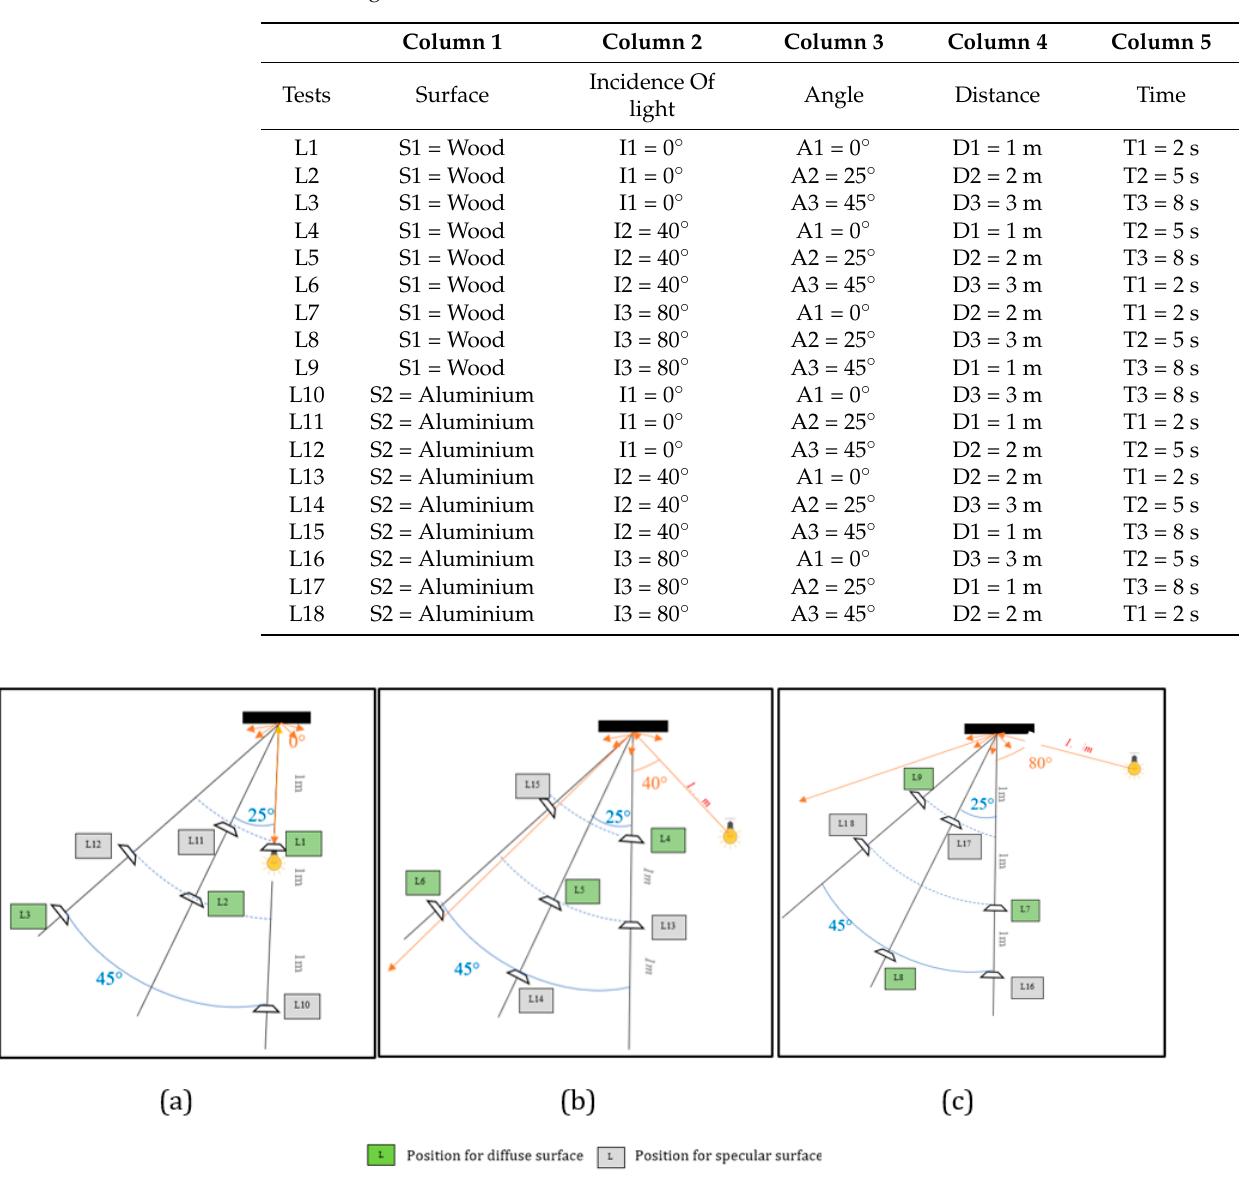
Figure 5. Different schematic configurations in view of the selected Taguchi plane L ()18: L represents the LiDAR position for each trial. ( a ) Different position of the sensor depending on the light incidence at 0°. ( b ) Different position of the sensor according to the light incidence at 40°. ( c ) Different position of the sensor in function of the light incidence at 80°.